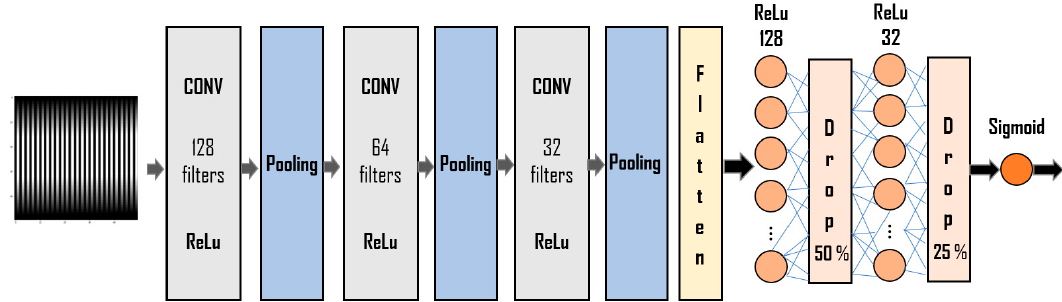
Figure 3. The architecture of the CNN model implemented to classify curves with pop-in and without pop-in events.